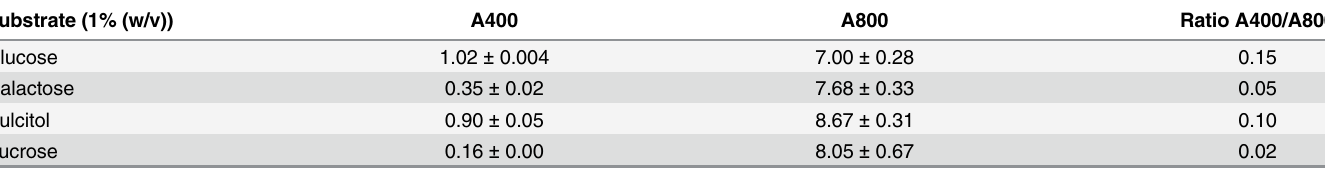
Table 1. Effect of various carbon sources on the production of the porphyrin-like